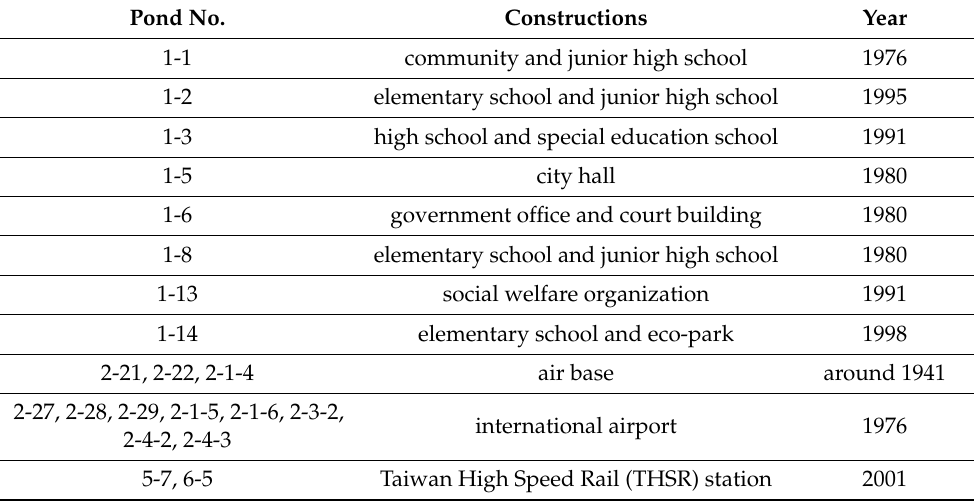
Table 1. Constructions made at the same location as ponds [50], adapted from Chen, C.P. Pond